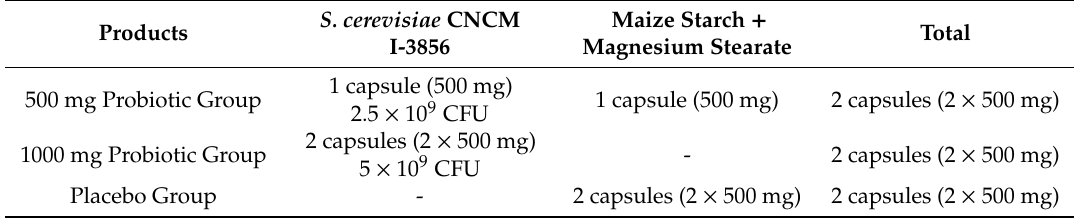
Table 2. Every subject consumed two capsules per day, just before breakfast with a glass of water. Table 2. Study